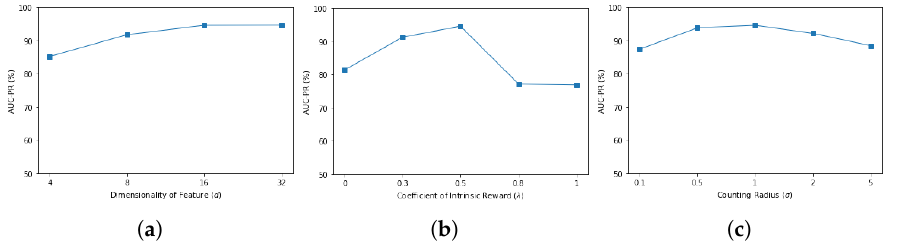
Figure 6. Impacts of Hyperparameters. ( a ) The contribution of representation dimensionality to model performance improvement decreases with the increase in dimension; ( b ) The introduction of intrinsic reward improves the model’s performance, but a high weight would be counterproductive; ( c ) A small counting radius will increase the intrinsic reward and thus lower the agent’s desire to explore the state space, while a large counting radius will render a small intrinsic reward and hence lead to insufficient exploration of